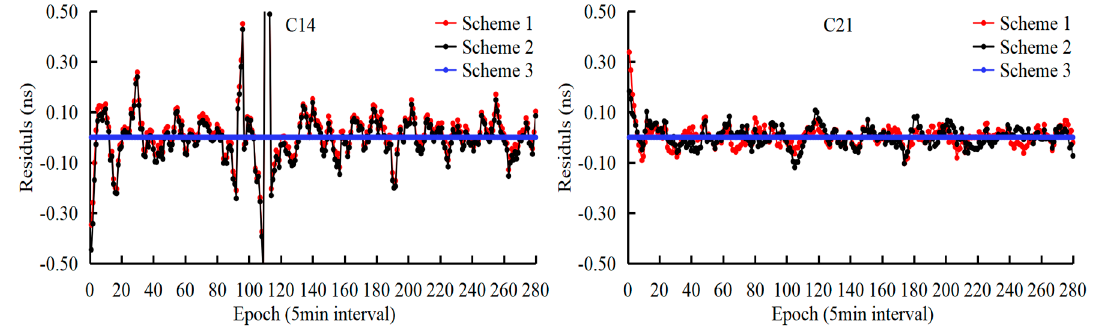
Figure 6. Residuals of each epoch on DOY 60 across the three schemes tested.